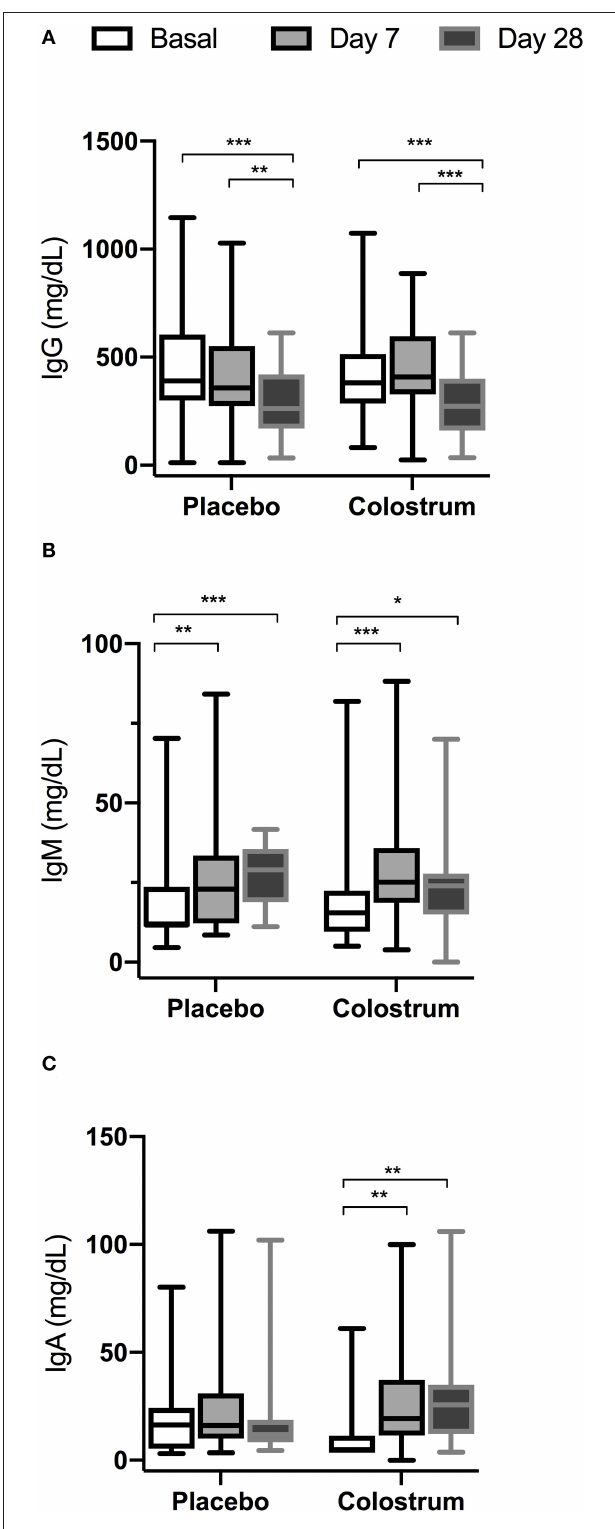
FIGURE 2 | Intragroup comparison of serum immunoglobulin levels at basal, day 7, and day 28. * p < 0.05, ** p < 0.001, *** p < 0.0001. (A) There was